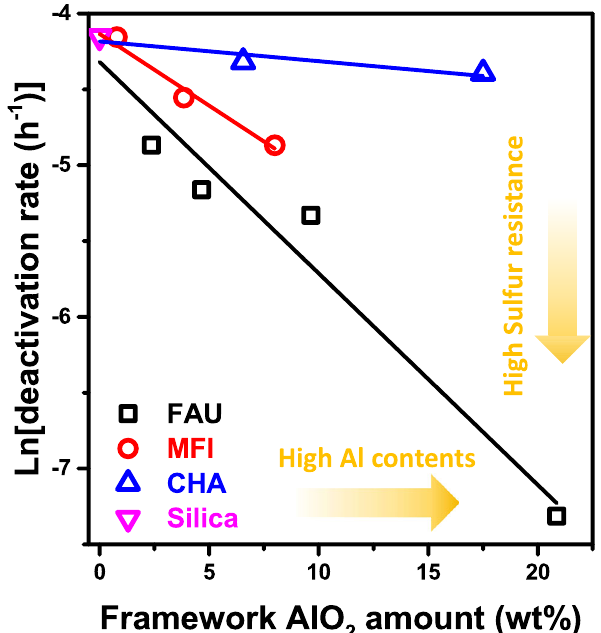
Fig. 4 Mechanism investigations of ABS trapping with two determination factors. The logarithm of the deactivation rate was plotted to the framework AlO 2 amount. Details of the reaction mechanism study are described in the reaction mechanism investigation section of the Supplementary Materials. Each data was obtained from SO 2 aging of physically mixed VWTi with Y zeolite (FAU, black), ZSM-5 (MFI, red), SSZ- 13 (CHA, blue) and silica (magenta) (Supplementary Fig. 16). The amount of framework Al was calculated by using theoretical Al amount from Si/Al 2 ratio and Al framework /Al total value from 27 Al-NMR data (details in Supplementary Fig. 19). The linearity of the model was shown by linear regression of various zeolites (Supplementary Table 3). Data of silica was included in all fi tting results for zero-point (at framework AlO 2 amount =